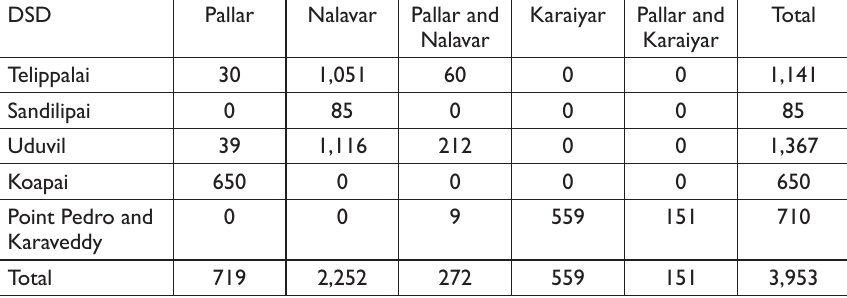
Karaiyar Pallar and Total Nalavar Karaiyar